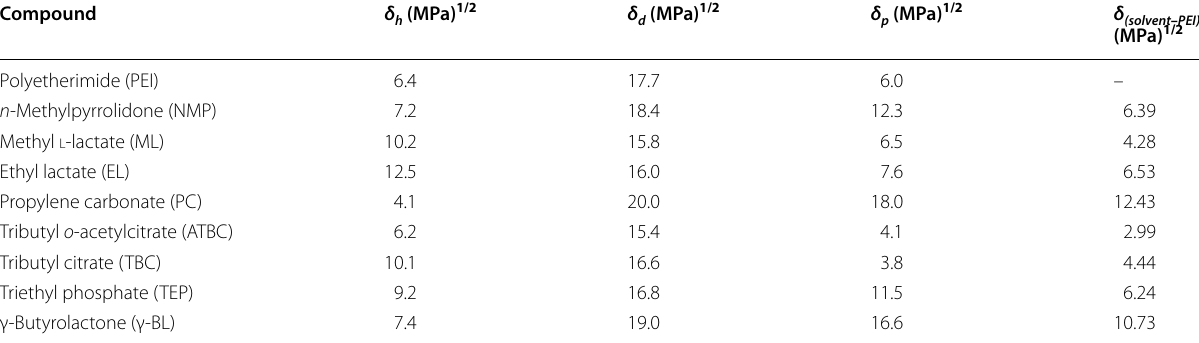
Table 2 Hansen solubility parameters for various solvents and the calculated PEI-solvent distance [17]